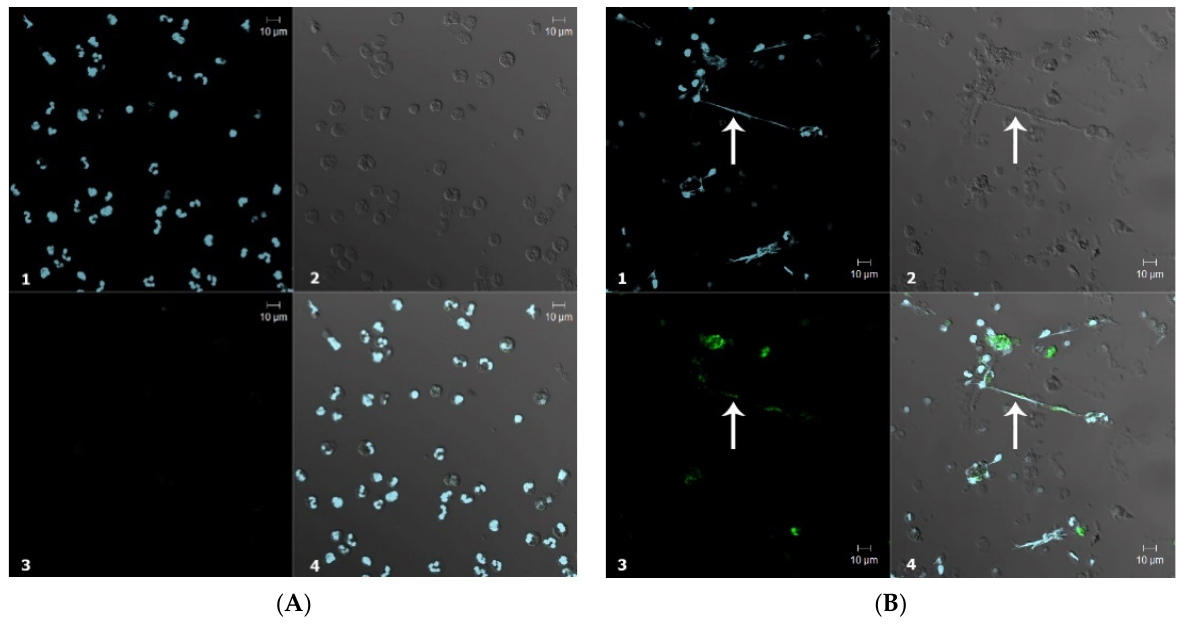
Figure 5. Confocal microscopy images of neutrophils incubated with 20 μ M CB ( A ) in the absence of PMA; ( B ) in the presence of 50 nM PMA. White arrow indicates the NETs. 1—DAPI (blue), 2— differential interference contrast, 3—fluorescence of oxidized CB upon laser excitation at 488 nm (green), 4—merge of 1, 2 and 3.